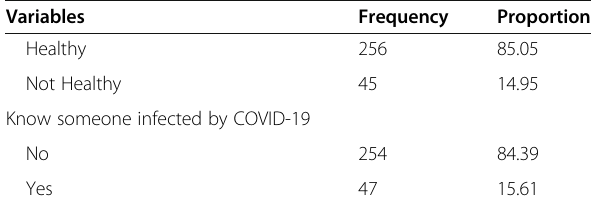
Table 1 Sociodemographic characteristics of school teachers